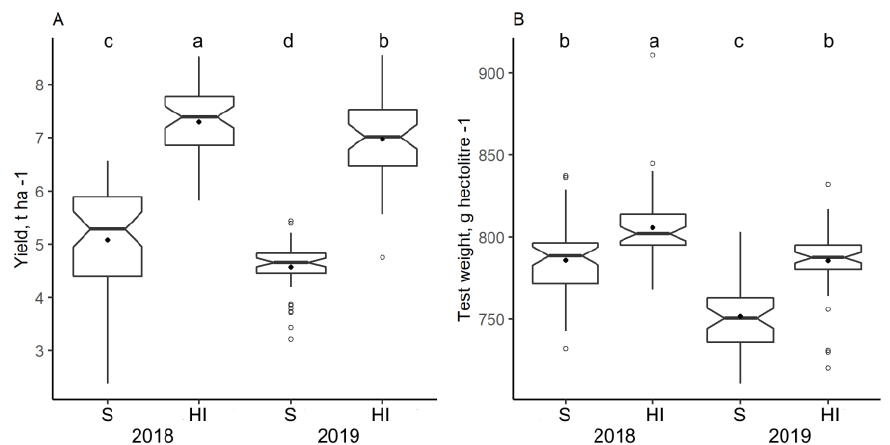
Figure 3. Winter wheat yield ( A ) and test weight ( B ) in sustainable (S) and high-input (HI) trials in 2018−2019. Means followed by the same letters are not significantly different ( p < 0.05, Tukey HSD test, n = 50).